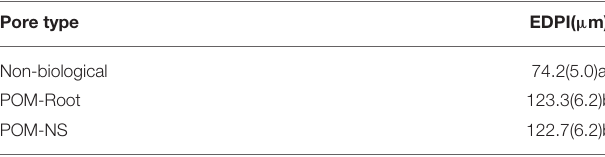
TABLE 2 | Effective distance of pore influence (EDPI) for the three studied pore types averaged across all studied